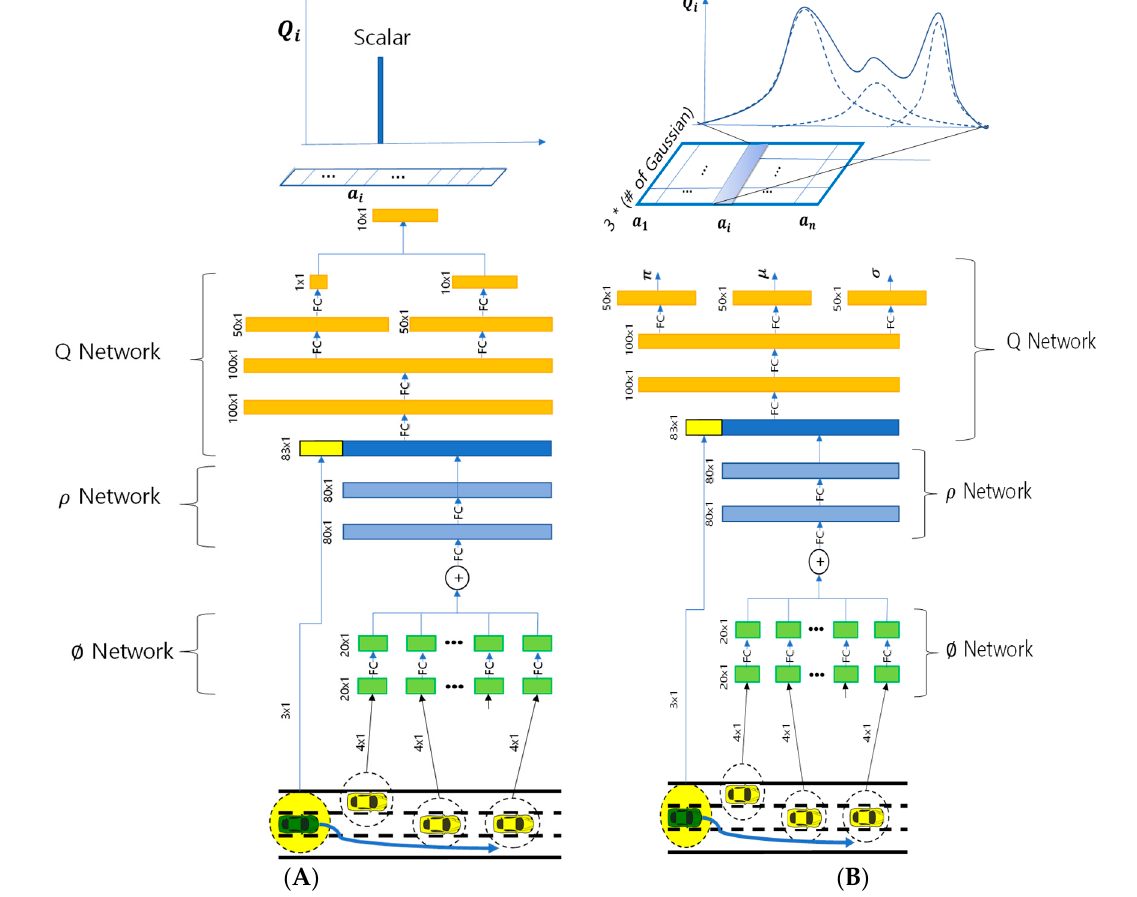
Figure 1. ( A ) DeepSet-Q and ( B ) DwGM-Q (DeepSet with Gaussian mixture Q network) architecture. Algorithm 1 : Training